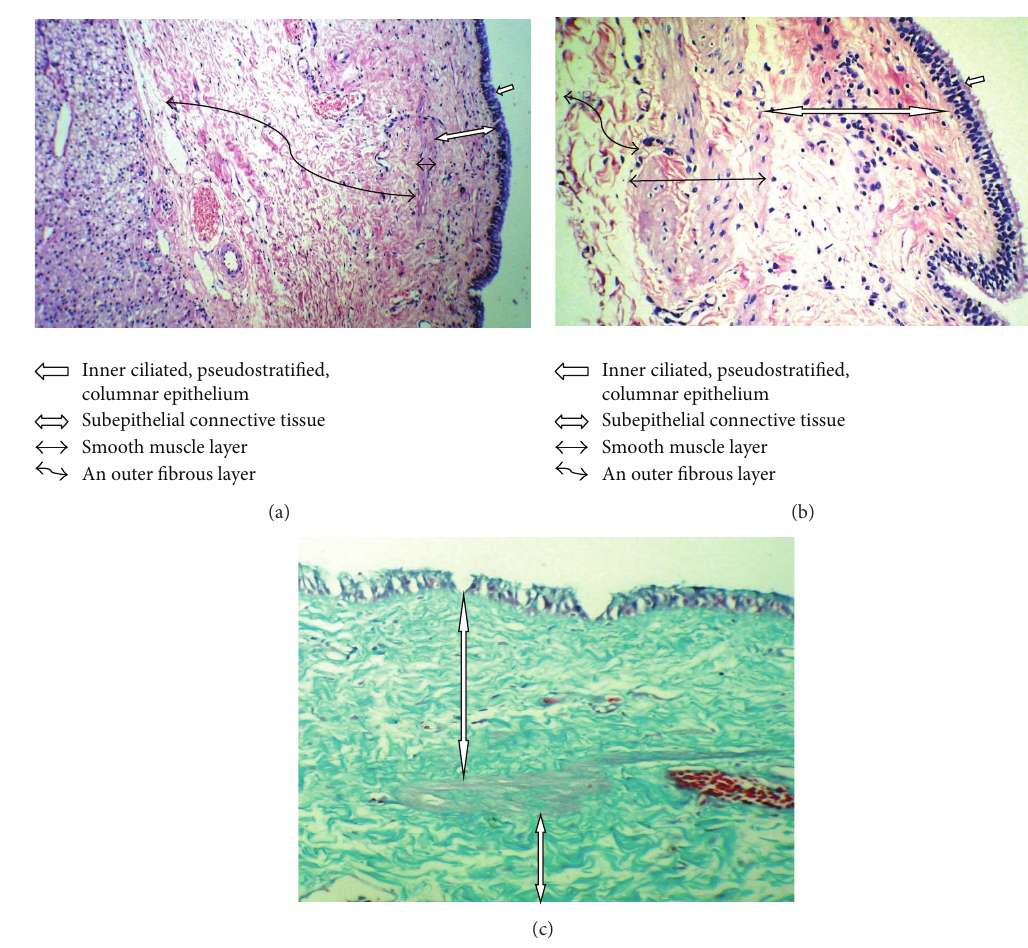
Figure 2: (a) Liver tissue and cyst wall composed of four typical layers (H&E × 250). (b) Four layers of cyst higher magnification (H&E × 400). (c) The fibrous layers of the cyst are stained green by Masson trichrome stain (⇕) (Masson trichrome stain × 400).